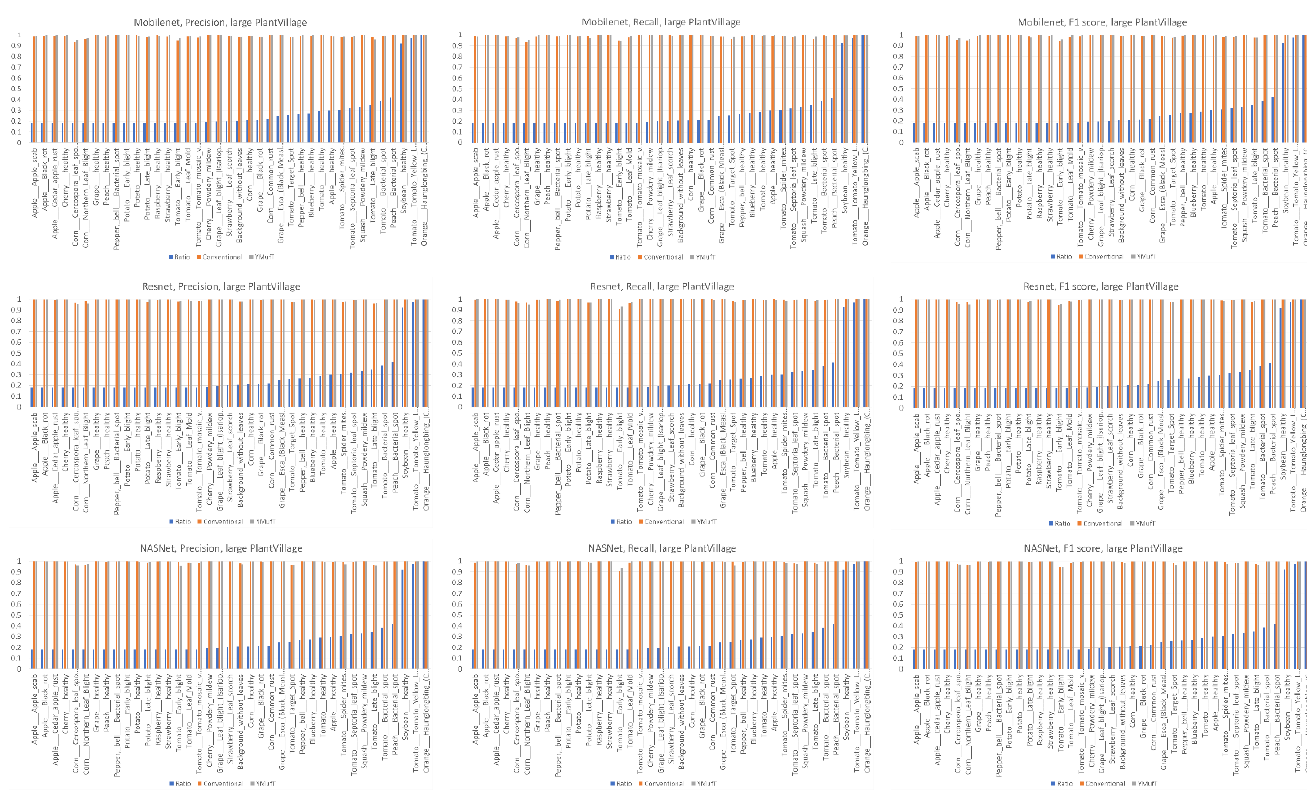
Figure 15. Overall performance on the large PlantVillage test set.